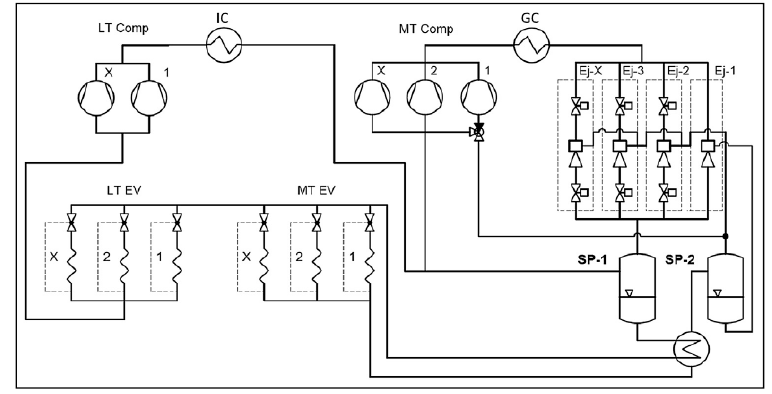
Figure 21. Multi-ejector CO 2 application in supermarkets [173].